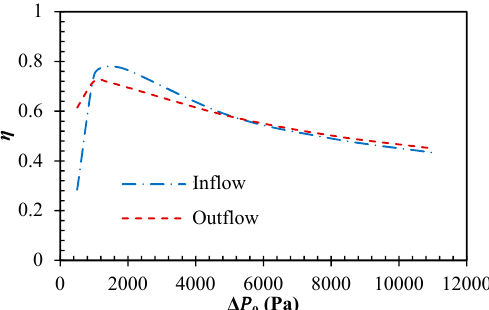
Figure 18. Comparison of the efficiency of outflow and inflow turbines over a range of turbine pressure differentials.